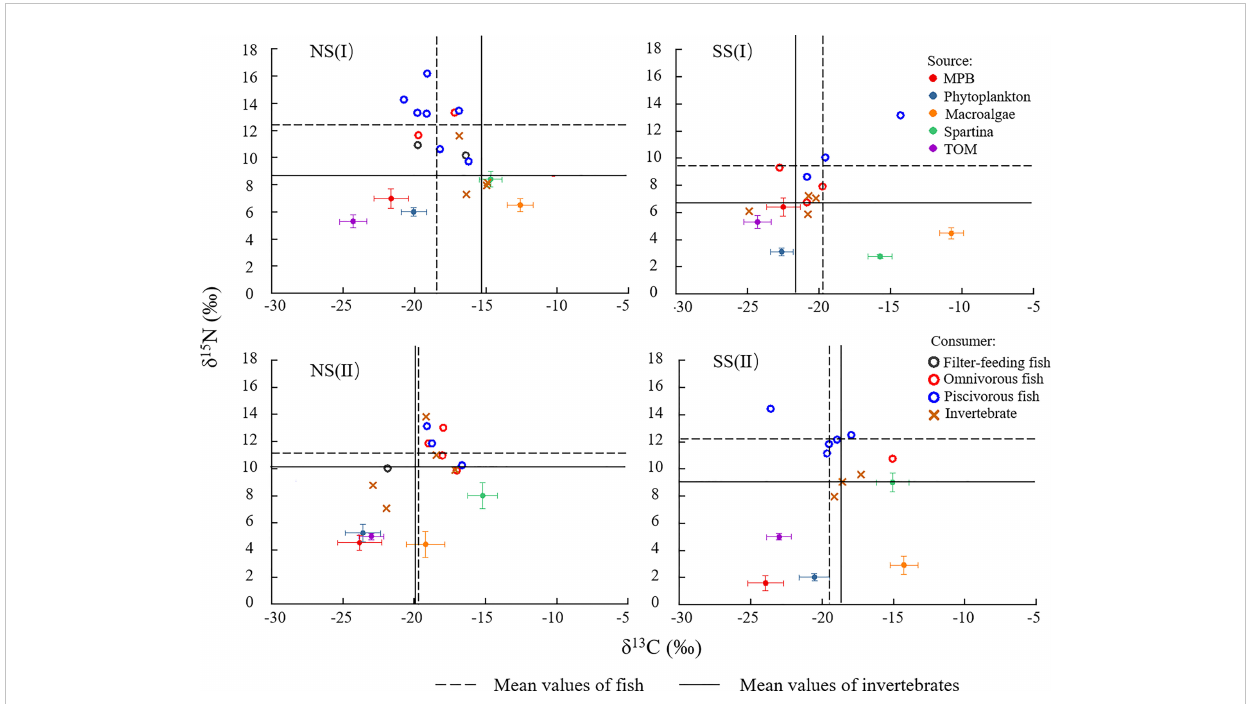
FIGURE 2 d 13 C and d 15 N stable isotope values of primary sources and consumers (MPB, microphytobenthos; TOM, terrestrial organic matter) in different regions and season. (I) Flood season (II) Non- fl ood season; (NS) Northern shore; (SS) Southern